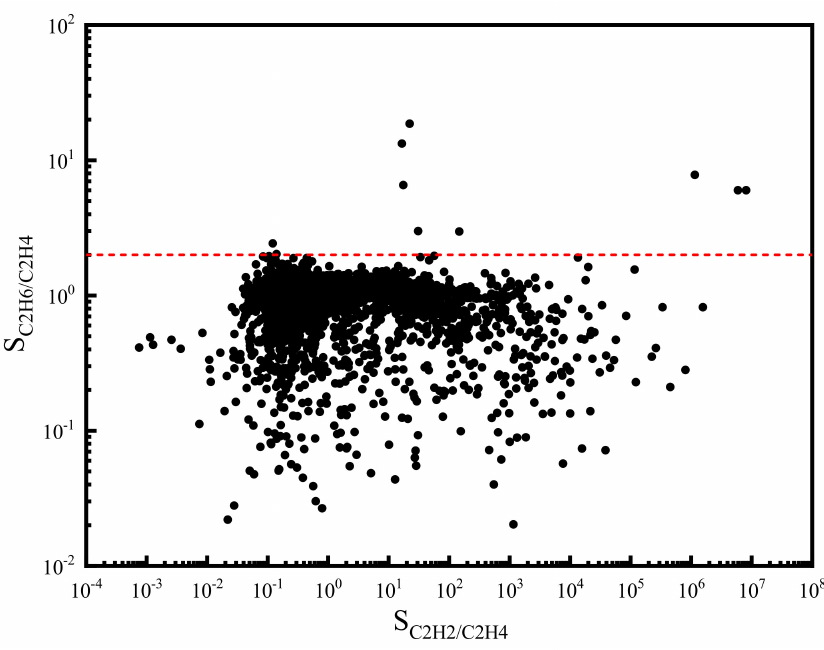
Figure 3. Adsorption selectivity of C 2 H 2 /C 2 H 4 and C 2 H 6 /C 2 H 4 in the ternary mixture at 298 K and 1 bar (The red dash line: S C2H6/C2H4 =